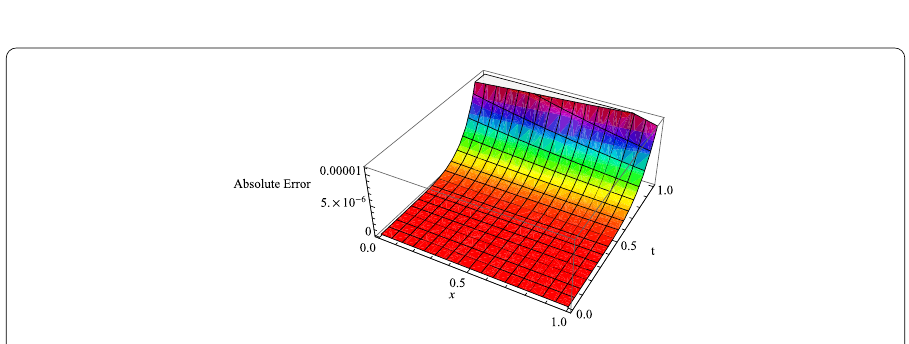
Figure 14 Plot of absolute error E 7 ( w ) = | w ( x , t ) – w 7 ( x , t ) | using HATM when λ = 1